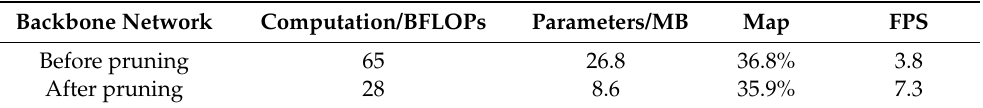
Table 2. Network pruning test results.